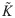
The concept behind Ripley’s K-function.
Panel A: Ripley’s K-function is defined as the average number of events within a predefined radius of any event, normalized for the event intensity (density) over the whole field of view. A set of radii is typically used to quantify the scale at which clustering (or dispersion) of events occurs (red circles). Panel B: Events within a given field of view could be distributed in many forms, including Complete Spatial Randomness (CSR), regularity and clustering (with or without a diffuse pool). Panel C: K˜ plots for two of the event distributions in Panel B: CSR (upper) and Clustering (lower). The dashed lines represent the upper and lower critical quantiles (Q01 and Q99).